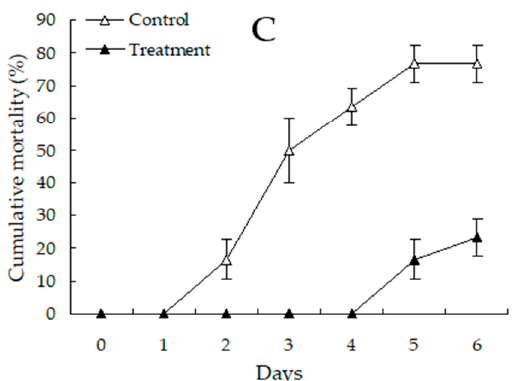
Figure 6. Protection of whiteleg shrimp by Bdellovibrio powder against the shrimp-pathogenic V. cholerae ( A ), V. parahaemolyticus ( B ), and V. vulnificus ( C ); control: 0 mg L − 1 Bdellovibrio powder; treatment: 0.8 mg L − 1 Bdellovibrio powder. Data are presented as the mean ± SD. Any differences observed are considered statistically significant at p < 0.05 according to Duncan’s test.